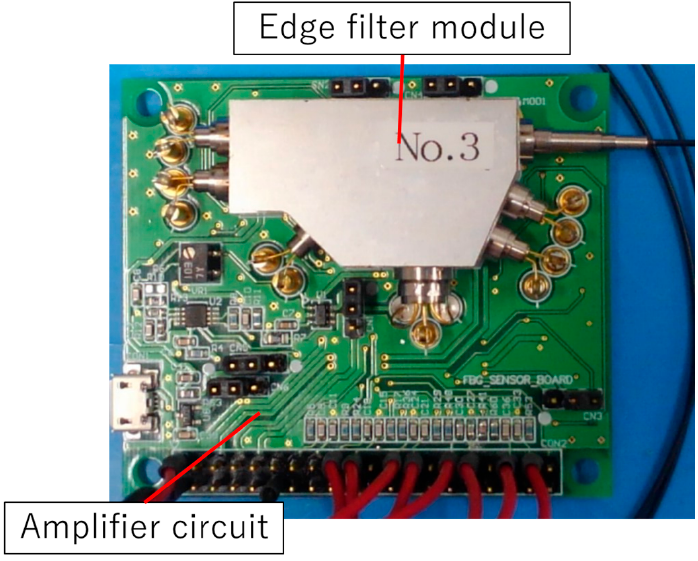
Figure 3. The edge filter module and amplifier circuit. The module contains an SLD, five PDs, a WDM, a half mirror, a SC/PC-pigtail and two edge filters.